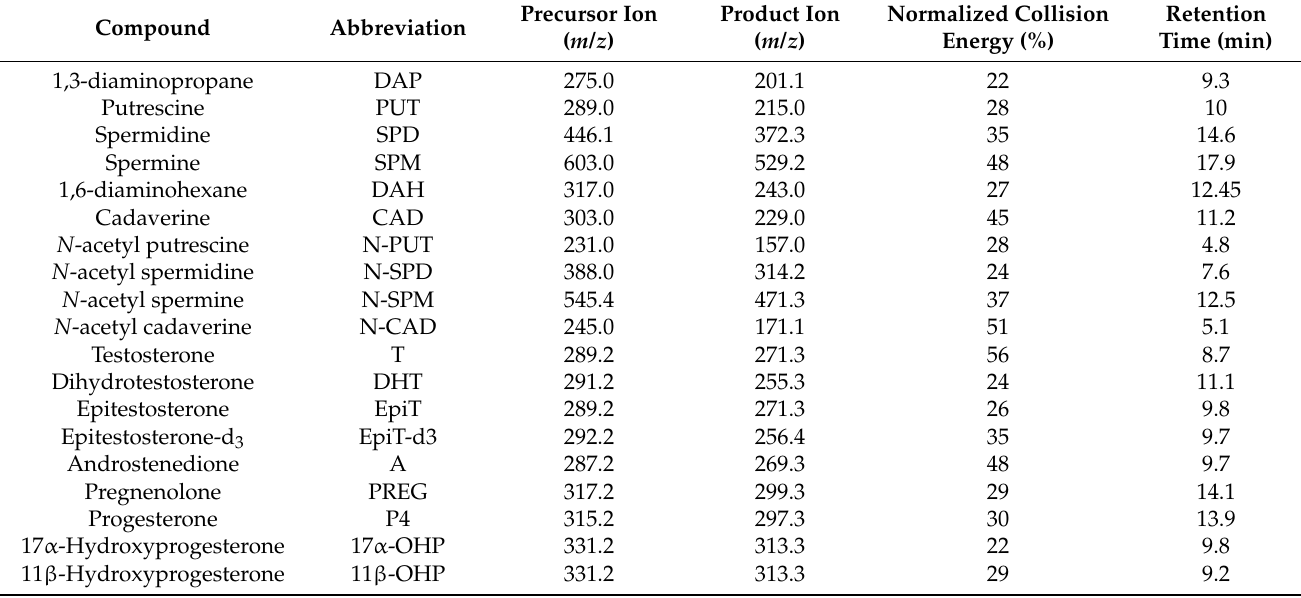
Table 4. Optimized MS information for polyamines and